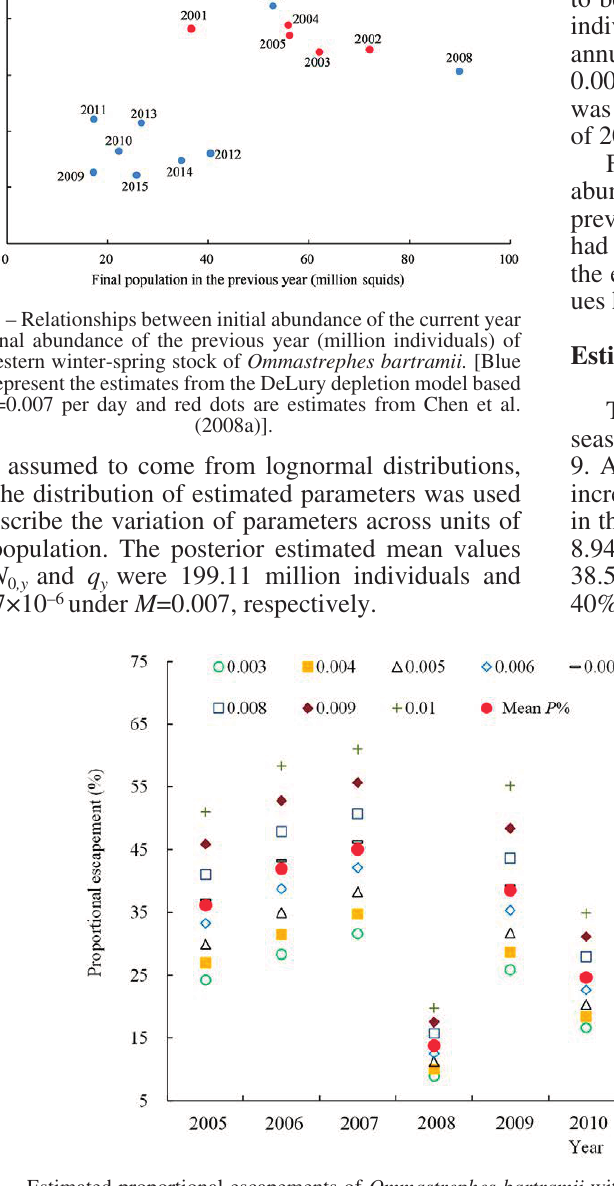
Fig. 9. – Estimated proportional escapements of Ommastrephes bartramii with different levels of natural mortality M (0.003-0.01 per day) from 2005 to 2015. (The “mean P%” was the average proportional escapement in each year with the M value of 0.003-0.01 per